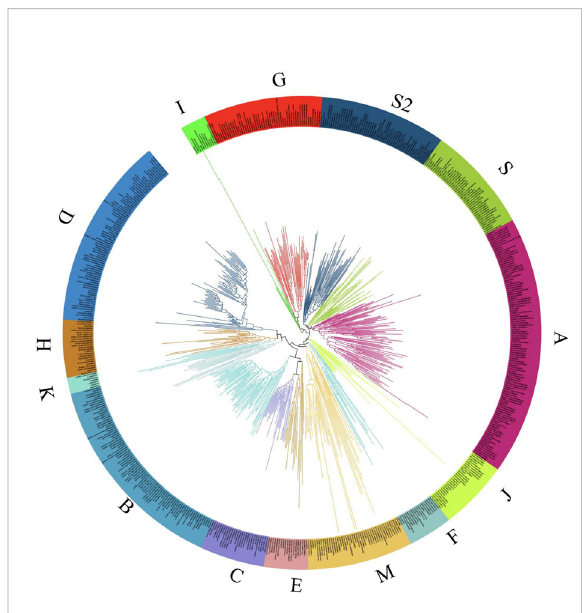
FIGURE 2 The bZIP gene family, phylogenetic tree analysis of 10 different plant species. The tree was constructed from 618 full bZIP protein sequences using MEGA X software, with 1000 bootstrap value and default parameters. Different color schemes shown represent cluster groups denoted by alphabetic letters (A-K, M, and